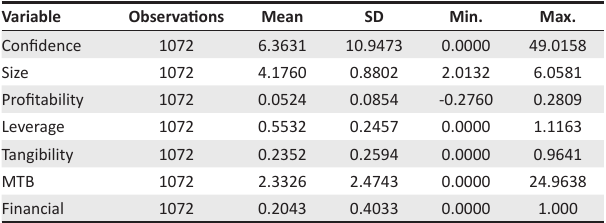
TABLE 2: Summary of descriptive